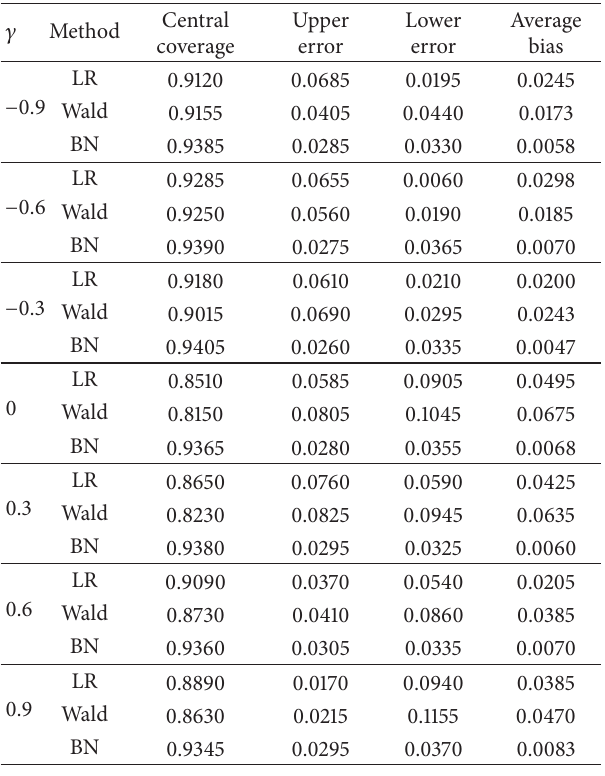
Table 1: Simulation results for 𝑛 = 10 , 95%